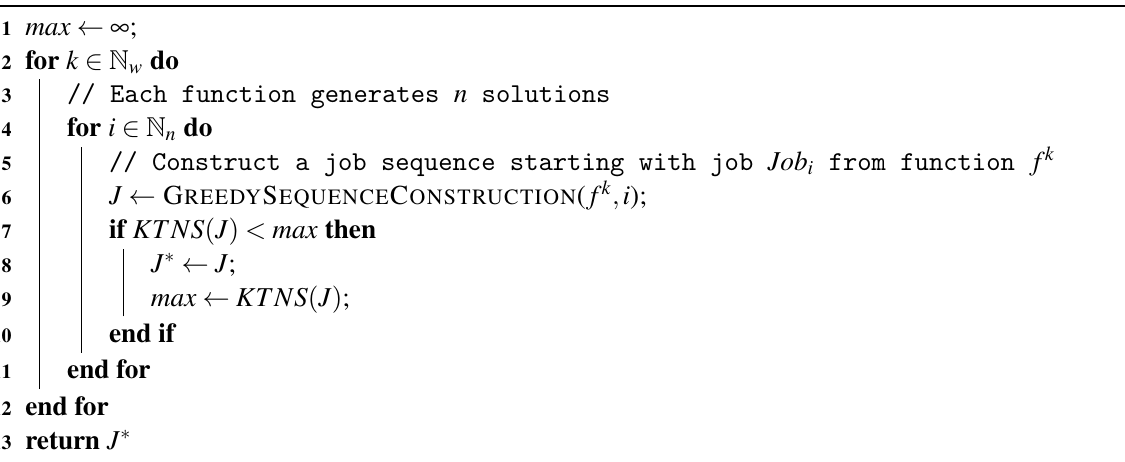
Algorithm 6: Method B EST S OLUTION ( { f 1 ;:::; f w }